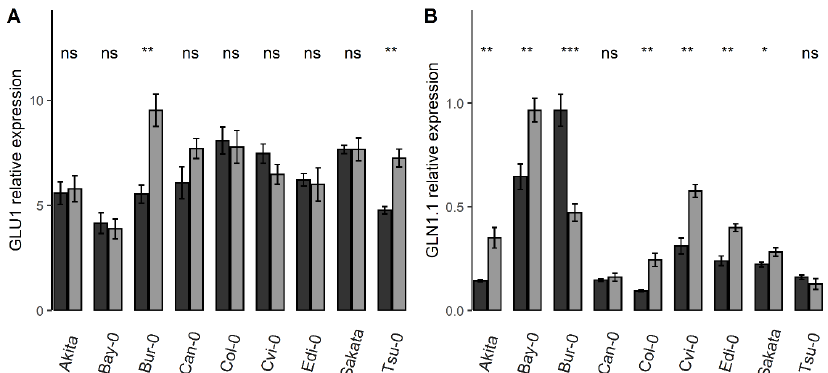
Figure 2. The relative expression of N metabolism-related genes varied depending on accessions and N conditions. Relative expression of GLU1 ( A ) and GLN1 . 1 ( B ) illustrating the differential responses to starvation among accessions (means ± SE). Stars indicate the significance of the difference between the means of the control and of the N starvation condition for each accession: ns non-significant, * p < 0.05, ** p < 0.01, *** p < 0.001, n = 8. Dark and light greys show the plant in the control and N starvation conditions, respectively.